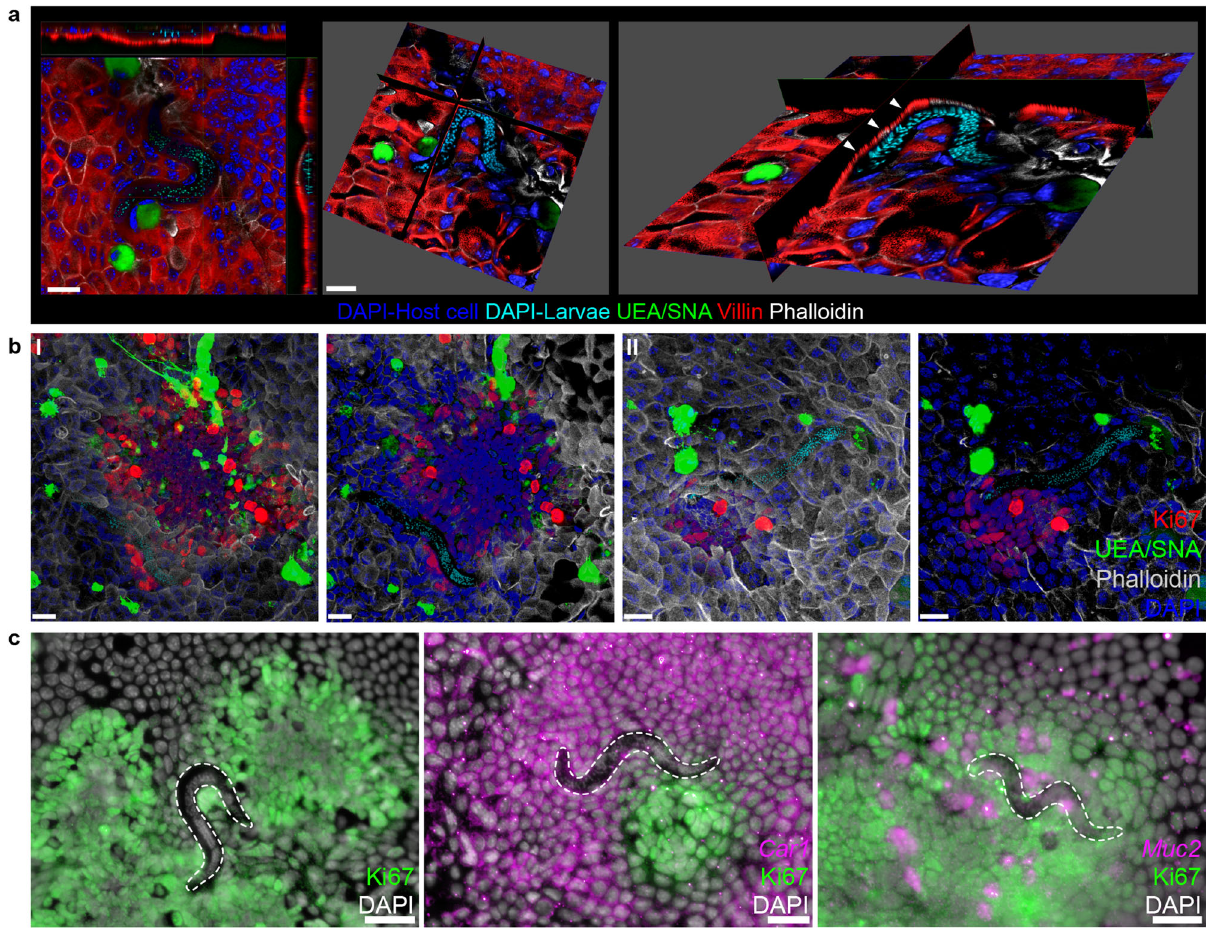
Fig. 3 Caecaloid — T. muris in vitro model reproduces in vivo infection. a , b Representative confocal immuno fl uorescence (IF) images of caecaloids infected with whipworm L1 larvae for 24 h. a Orthogonal slice visualising enterocyte microvilli (villin staining in red) above the larvae (white arrowheads). Scale bars 20 μ m. b Complete z-stack projection showing larvae infecting IECs within or adjacent to Ki-67 + (red) dividing centres. In green, the lectins UEA and SNA bind mucins in goblet cells; in blue and aqua, DAPI stains nuclei of IECs and larvae, respectively; and in white, phalloidin binds to F-actin. Scale bars 20 μ m. IF imaging experiments on T. muris- infected caecaloids were done in triplicate across more than ten independent replicas using three caecaloid lines derived from three C57BL/6 mice. c Representative images of T. muris -infected caecaloids (72 h p.i) showing L1 larvae infecting cells within or adjacent to Ki-67 + (green) dividing centres, speci fi cally Car1 + enterocyte progenitors and Muc2 + DSCs (magenta) visualised by IF and mRNA ISH by HCR. In white DAPI stains nuclei. Scale bars 15 μ m. HCR imaging experiments on T. muris- infected caecaloids were done in triplicate across two independent replicas using two caecaloid lines derived from two C57BL/6